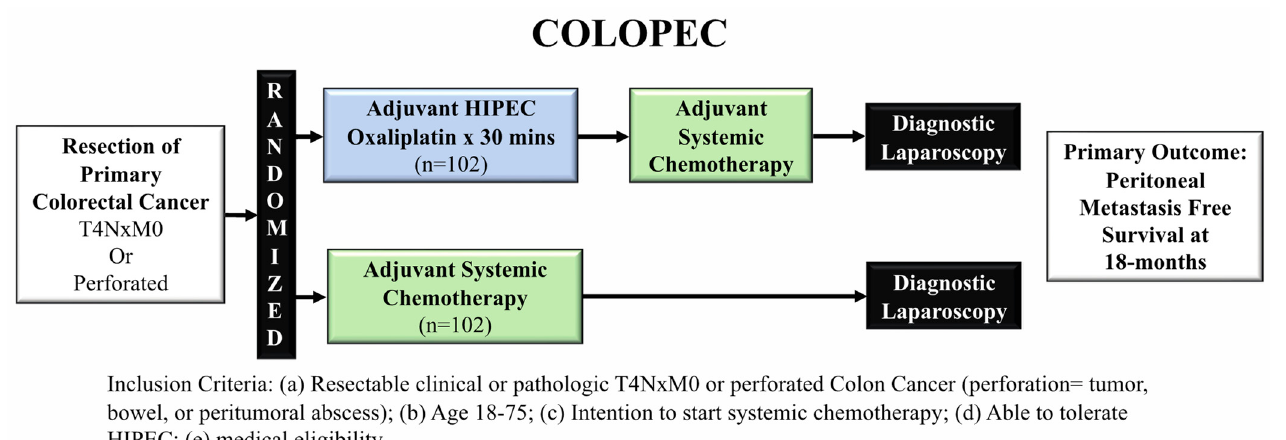
Figure 3. COLOPEC trial schema comparing adjuvant HIPEC to adjuvant systemic therapy in high-risk patients for peritoneal metastases.